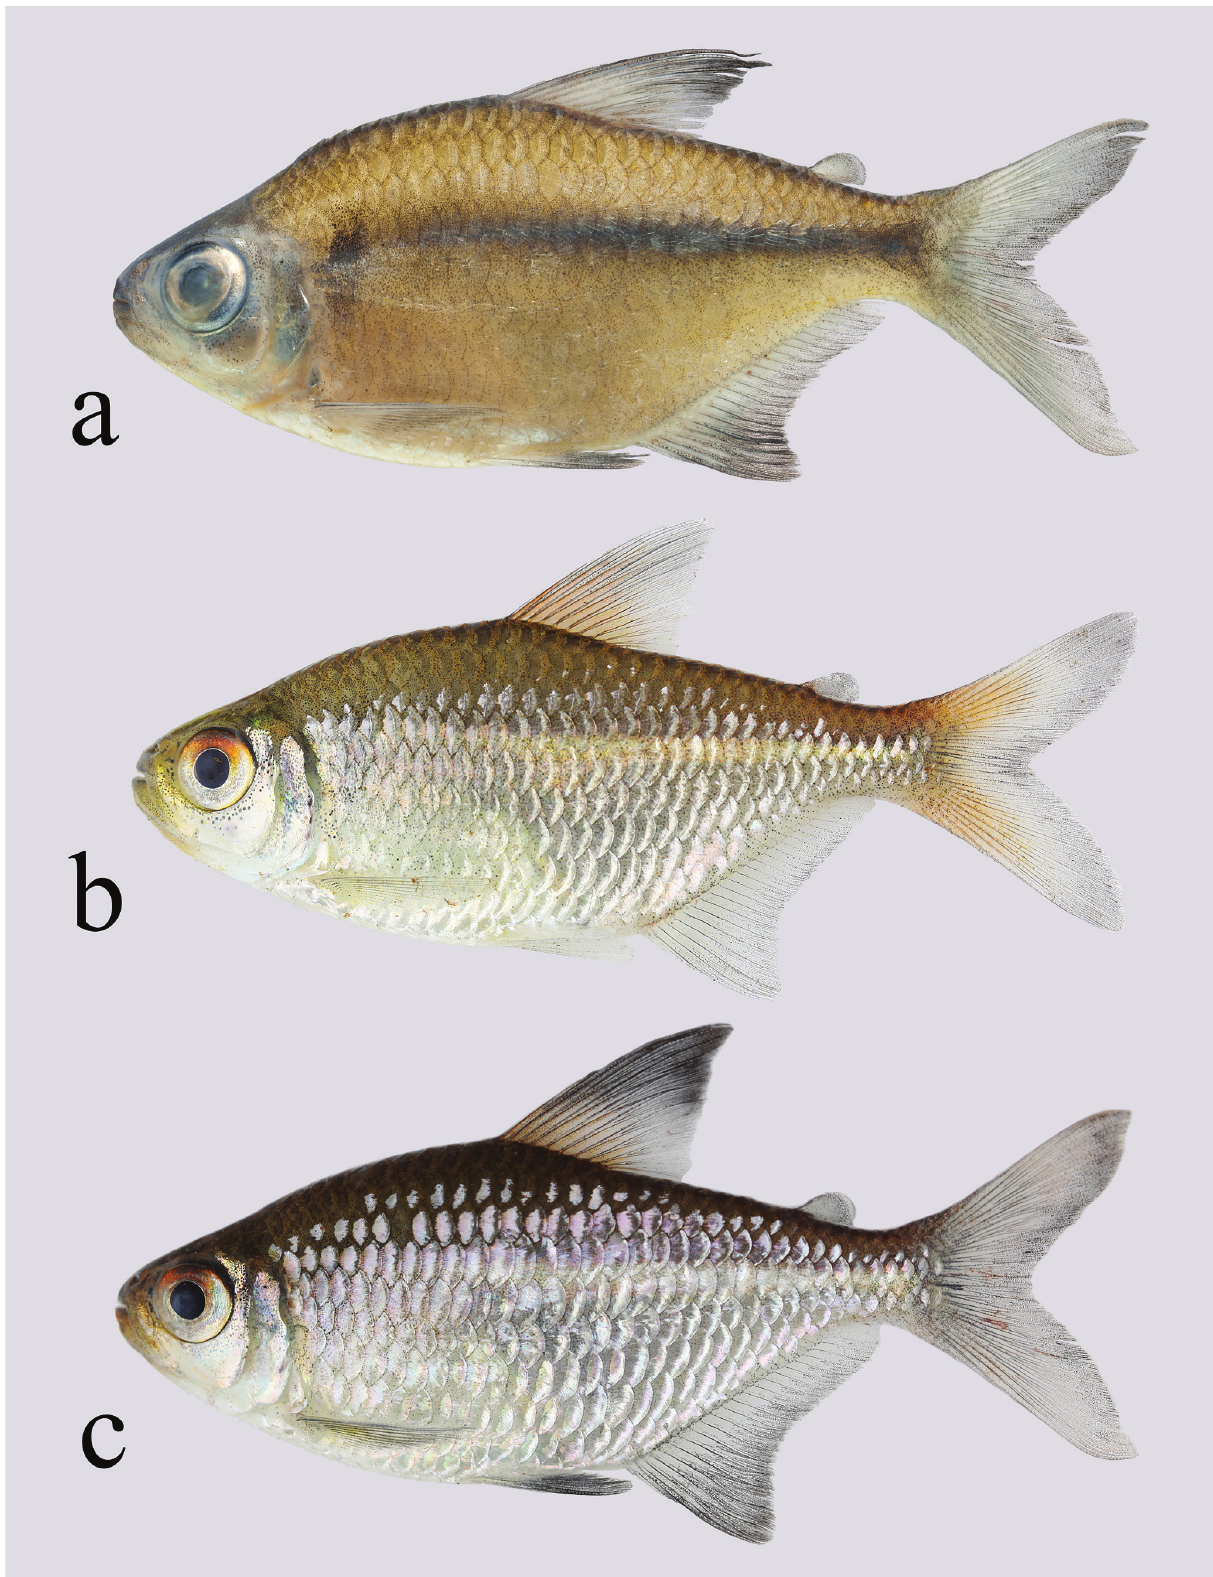
Fig. 1. Moenkhausia mutum , new species, Brazil, Mato Grosso, Nova Mutum, rio Arinos drainage, rio Tapajós basin: (a) holotype alcohol preserved, MZUSP 117071, 65.3 mm SL, (b) paratype, live coloration, MZUSP 117072, 53.6 mm SL, collected with the holotype, (c) holotype, live